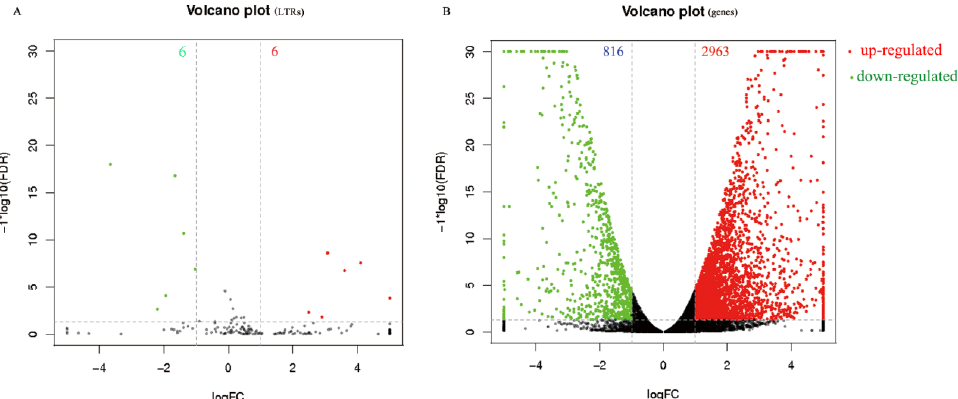
Figure 5. Volcano plot of identified DELs and DEGs between ApNPV-infected A . pernyi larval midgut and uninfected controls. ( A ) Volcano plot of differentially expressed LTRs (DELs). ( B ) Volcano plot of differentially expressed genes (DEGs). The red spots represent significantly up-regulated DELs and DEGs. The green spots represent significantly down-regulated DELs and DEGs. The black spots indicate absence of significantly di ff erent